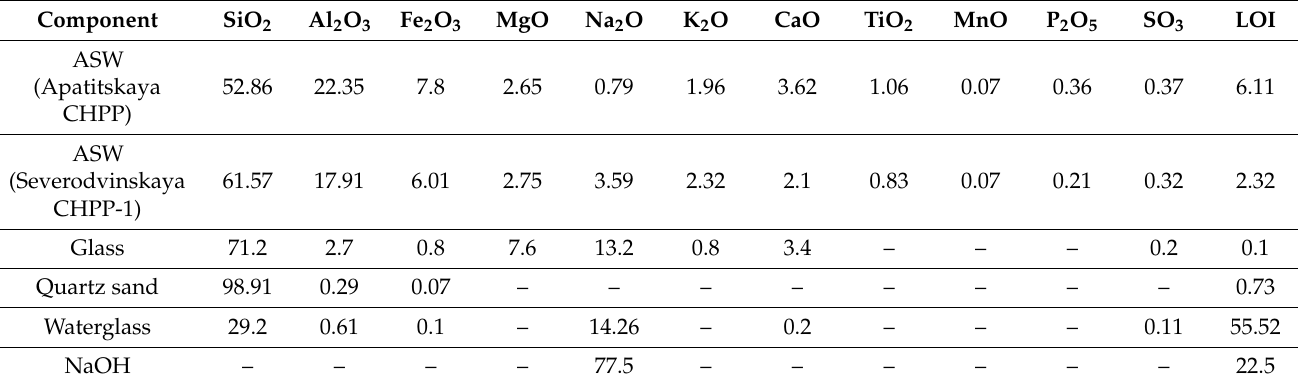
Table 1. Chemical composition of raw materials,